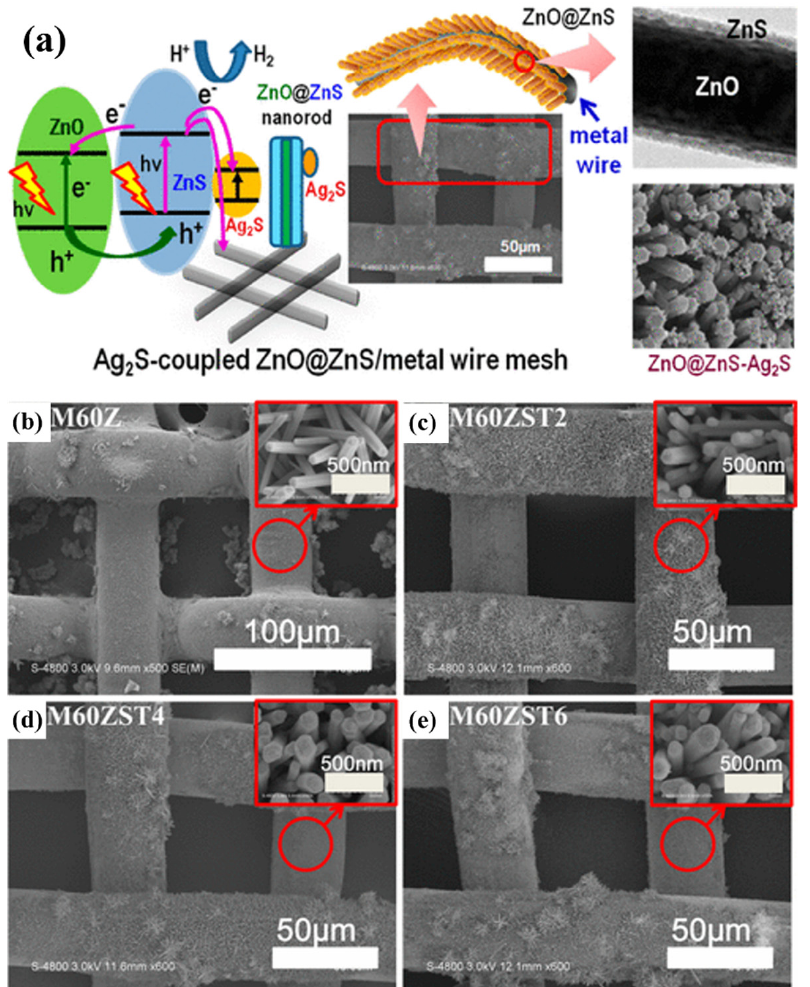
Figure 12. ( a ) The morphology and a related mechanism of the metal sulfide-based photocatalysts